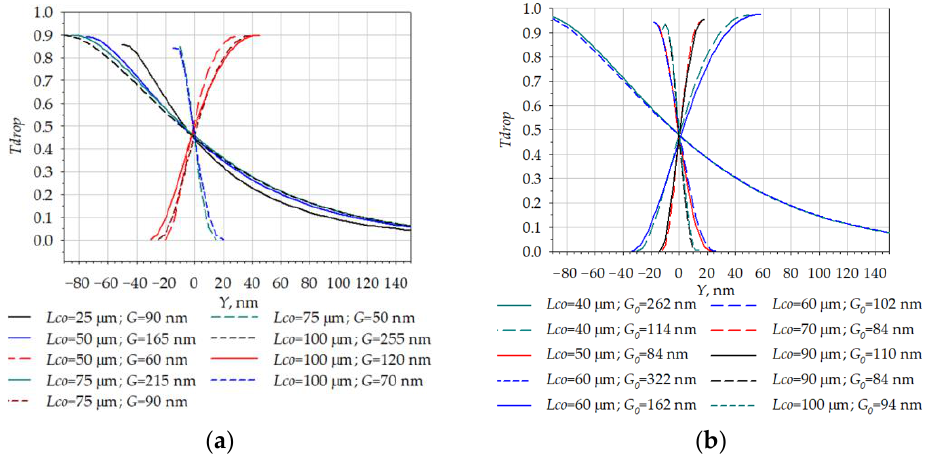
Figure 14. Dependence of the optical transmission coefficient on the inertial mass linear displacement along axis Y for the OMT with single-plane waveguides (Scheme 1). ( a ) Waveguides with dimensions of 300 × 1000 nm; ( b ) Waveguides with dimensions of 300 × 750 nm.